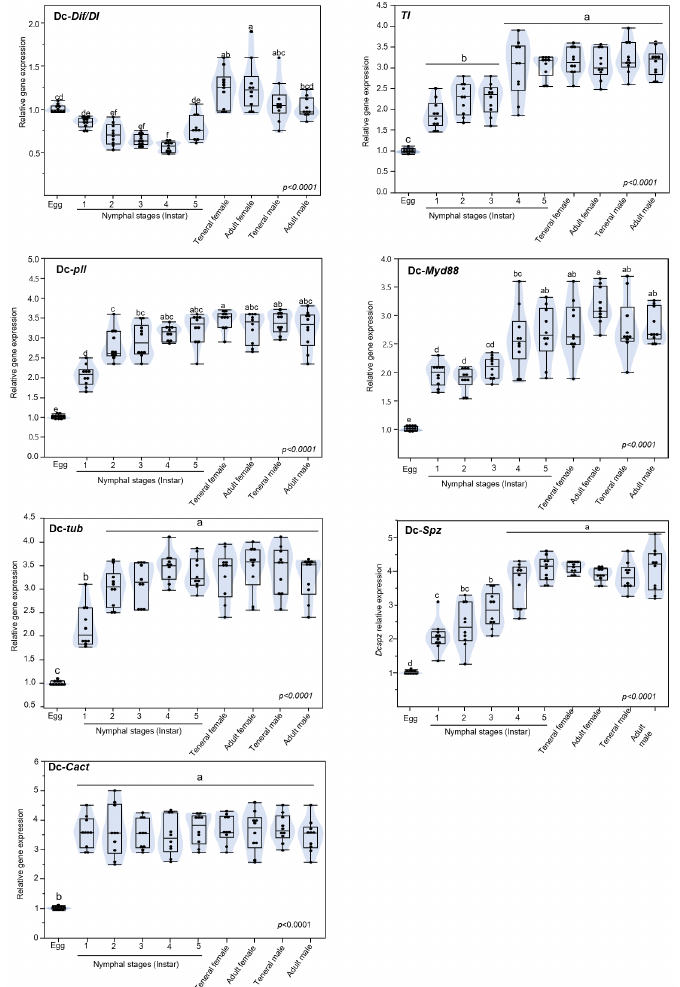
Figure 7. The relative expression level of genes involved in Toll pathway in D. citri . Dorsal related immunity factor/Dorsal ( Dif/DI ), Pelle ( pll ), Tube ( tub ), Cactus ( cact ), Toll ( TI ), Myeloid differentiation factor 88 ( Myd88 ), and Spaetzle ( spz ) genes expression in different developmental stages of D. citri. Expression of each gene is presented with an overlapping boxplot, violin plot, and scatter plot. In the boxplot, whiskers represent the maximum and minimum values, horizontal thick lines in the middle of the box shows the median, and boxes show the middle 50% of scores (i.e., the range between the 25th and 75th percentile, interquartile ranges (IQR)). Differences between developmental stages were statistically evaluated for each gene by the one-way ANOVA (analysis of variance) with Turkey HSD ( p <